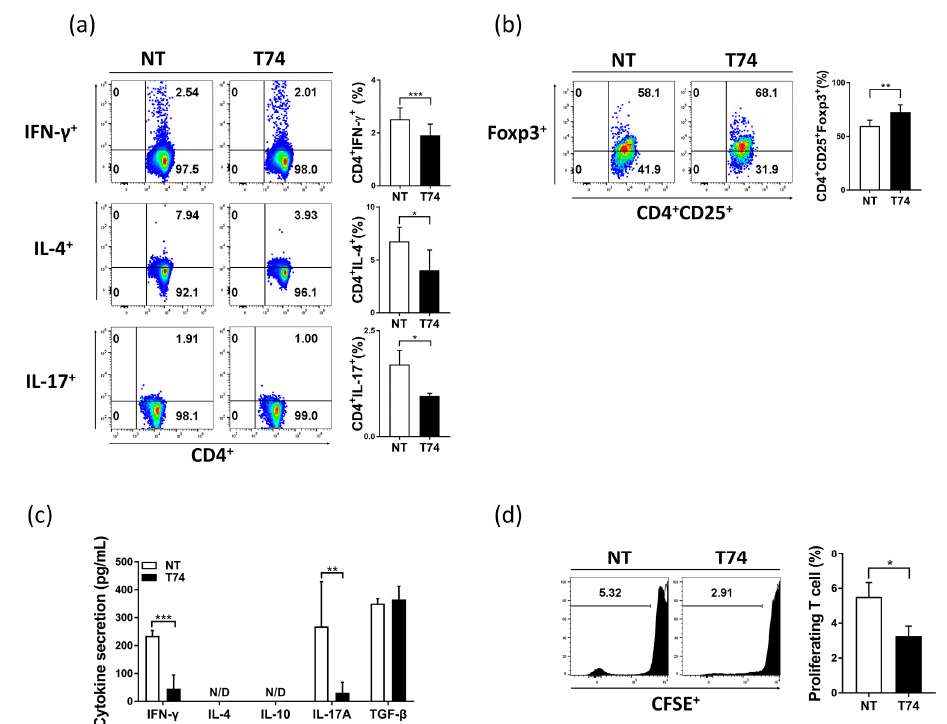
Figure 2. Immunosuppressive characteristics of T74-DCs. Enriched T cells were co-cultured with each DC subset at a ratio of 1:10 for 72 h. ( a ) T cell subpopulations were analyzed by flow cytometry. The percentage of induced Th1 (CD4 + IFN- γ + ), Th2 (CD4 + IL-4 + ), Th17 (CD4 + IL-17A + ), and ( b ) Treg (CD4 + CD25 + Foxp3 + ) is shown on the dot plots. ( c ) Th1/Th2/Th17- and Treg-related cytokine levels in supernatants from DC/T cell co-cultures were measured by ELISA. ( d ) CD3 + T cells were stained with CFSE to measure T cell proliferation. All data are representative of four independent experiments and are expressed as the mean ± SEM, n = 4. * p < 0.05, ** p < 0.01, *** p < 0.001. N/D: not detected.